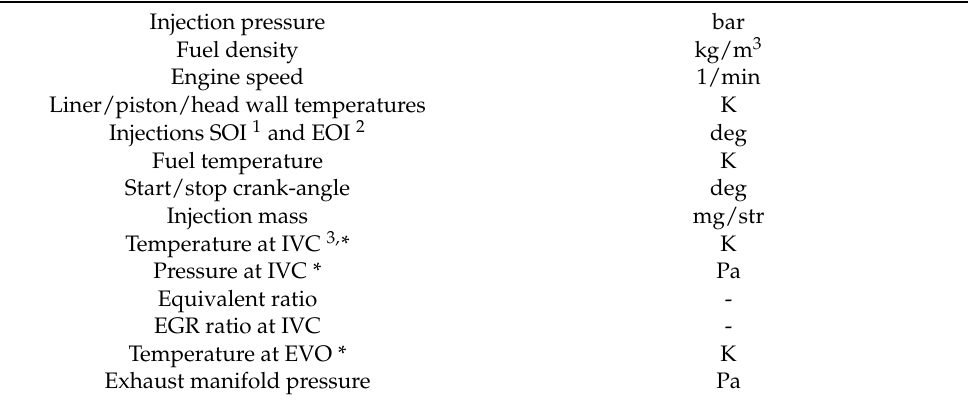
Table 6. Model input specification with required units.